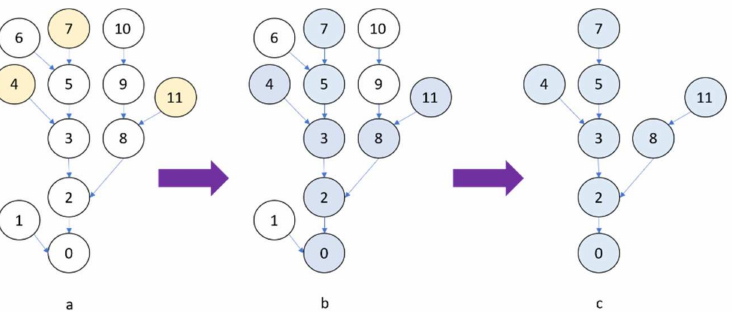
Figure 2. ( a ) The original tree; the yellow nodes show the nodes with the highest extinction values ( b ) Blue nodes represent the path from the three leaf nodes with the highest extinction values to the root ( c ) Results of the modification of nodes is not marked in